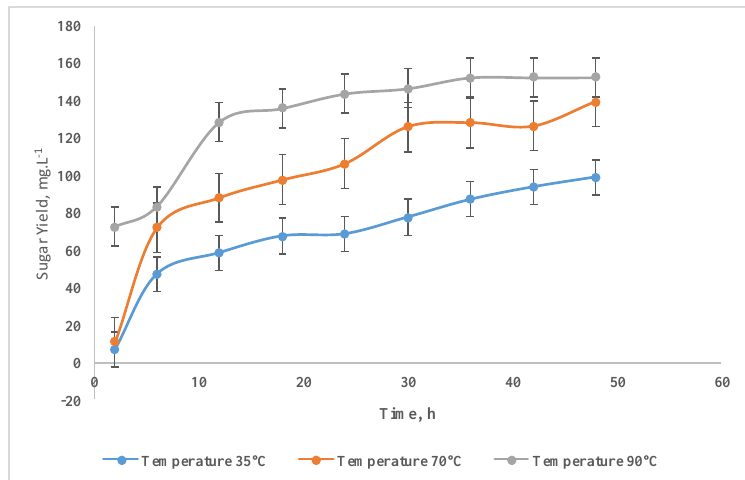
Figure 2. Effect of temperature on sugar yield during the enzymatic hydrolysis process using 60 FPU/g cellulose (organosolv pretreatment at conditions of 55% volume ethanol, temperature of 120 °C, and reaction time of 60 min).